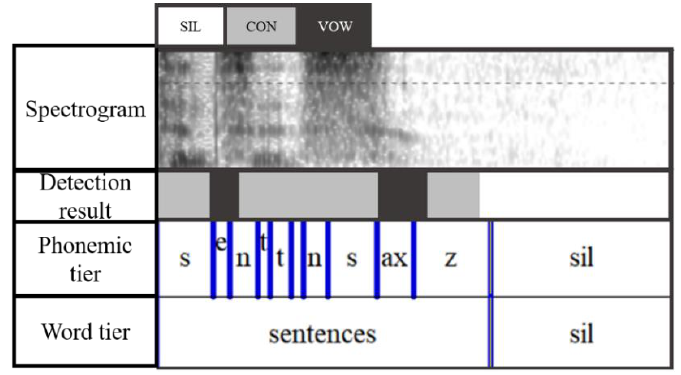
Figure 3. A sample result of the consonantal and vocalic interval detection.